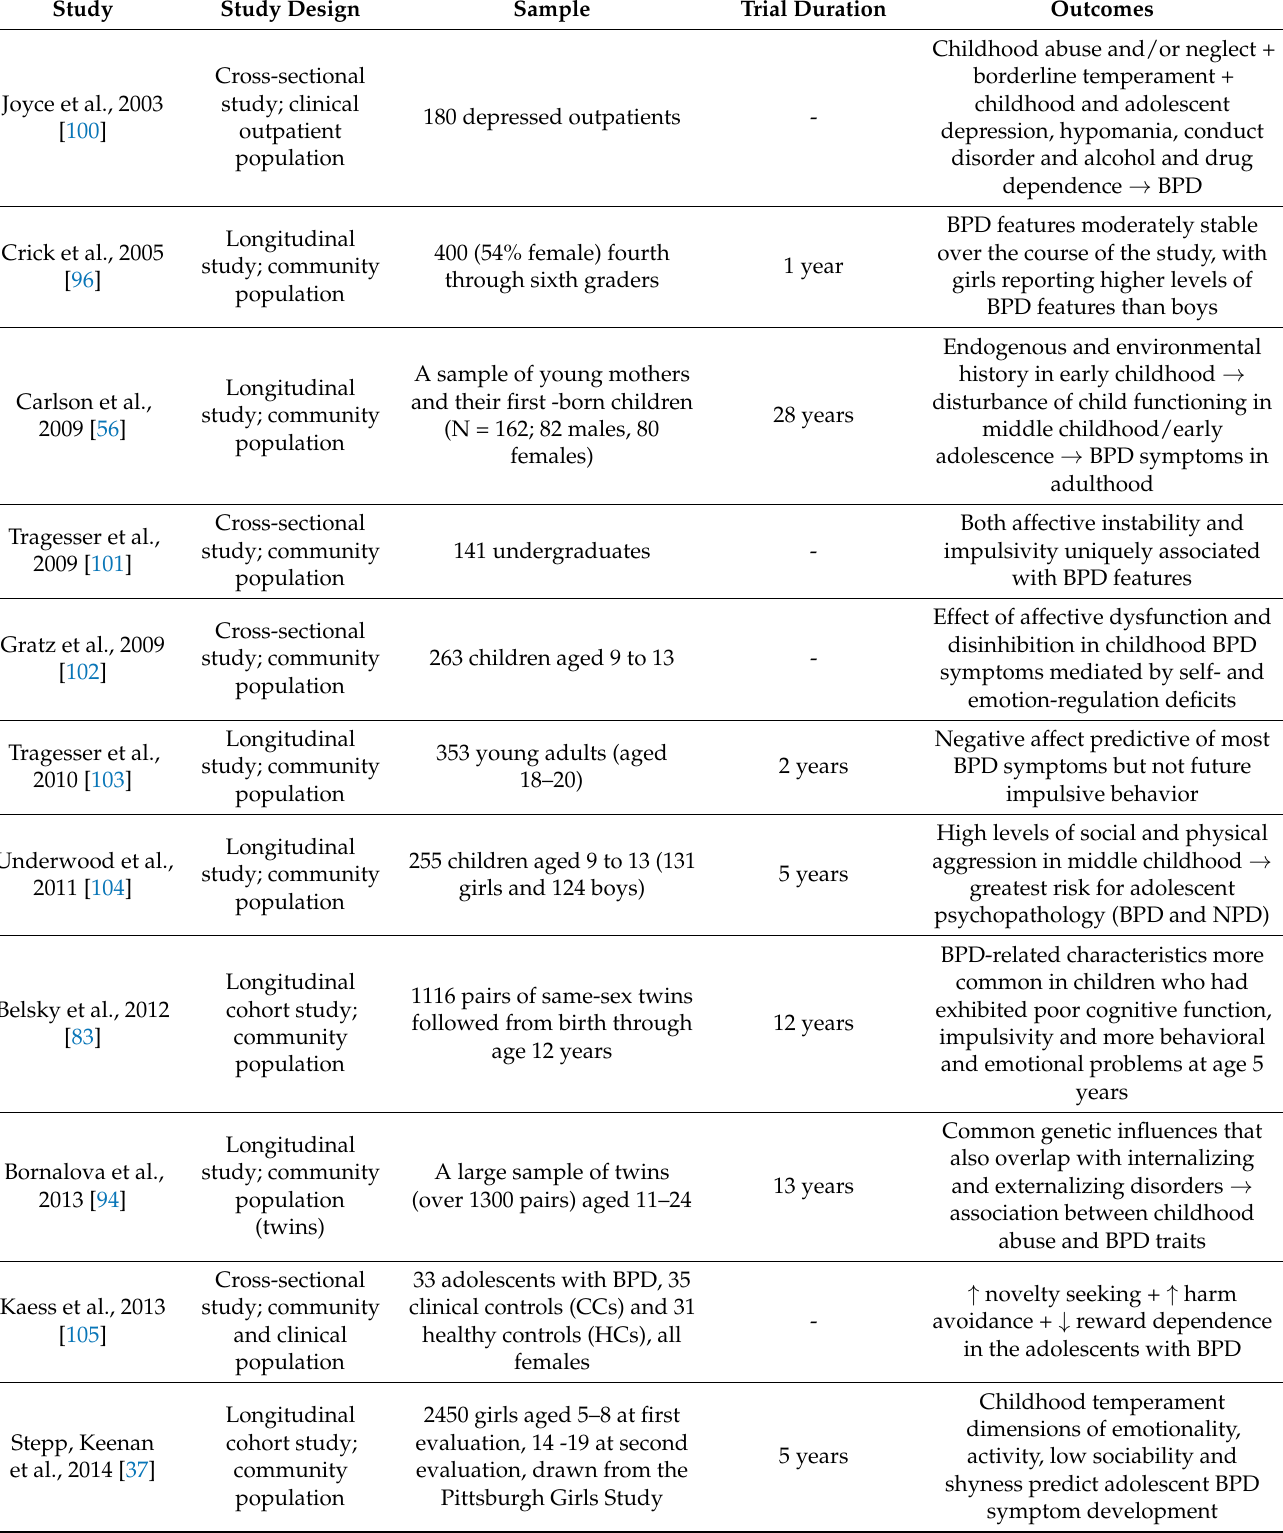
Table 2. Studies on temperamental and personality